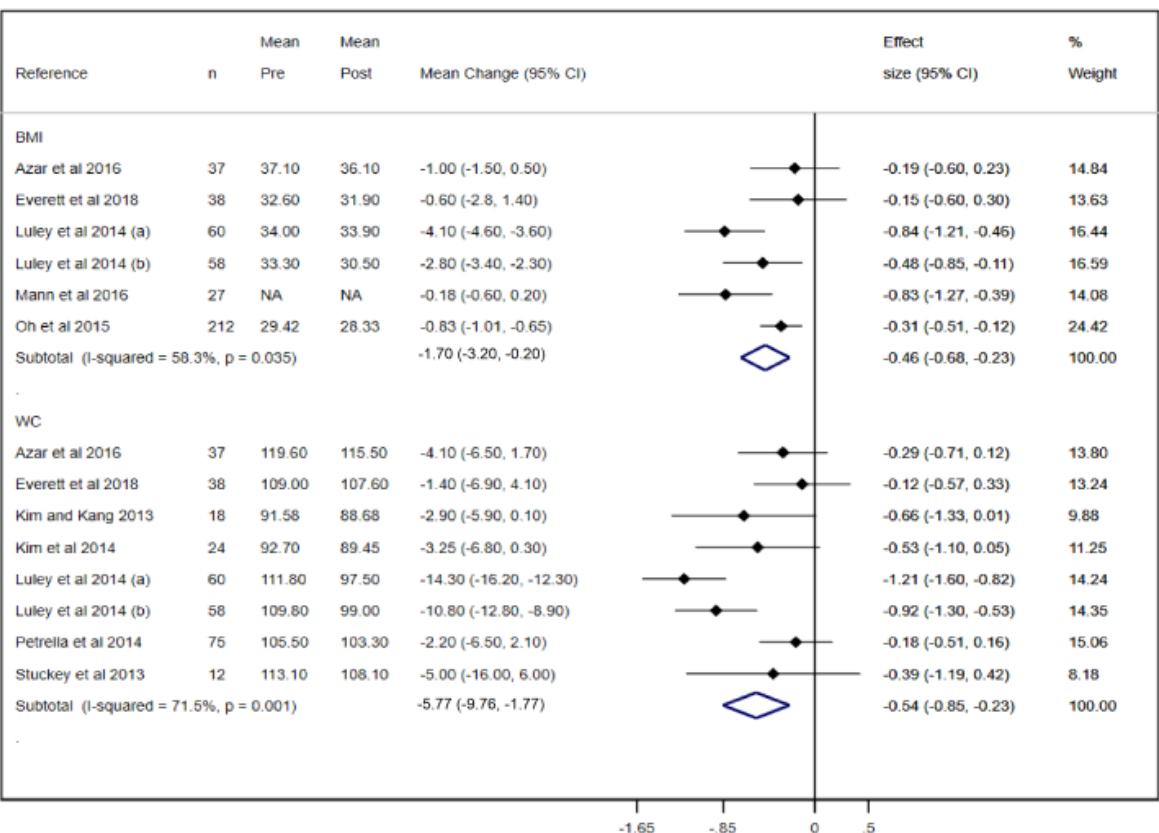
Figure 3. Forest plot of meta-analysis of mean changes and effect sizes for body composition parameters. WC: waist circumference.